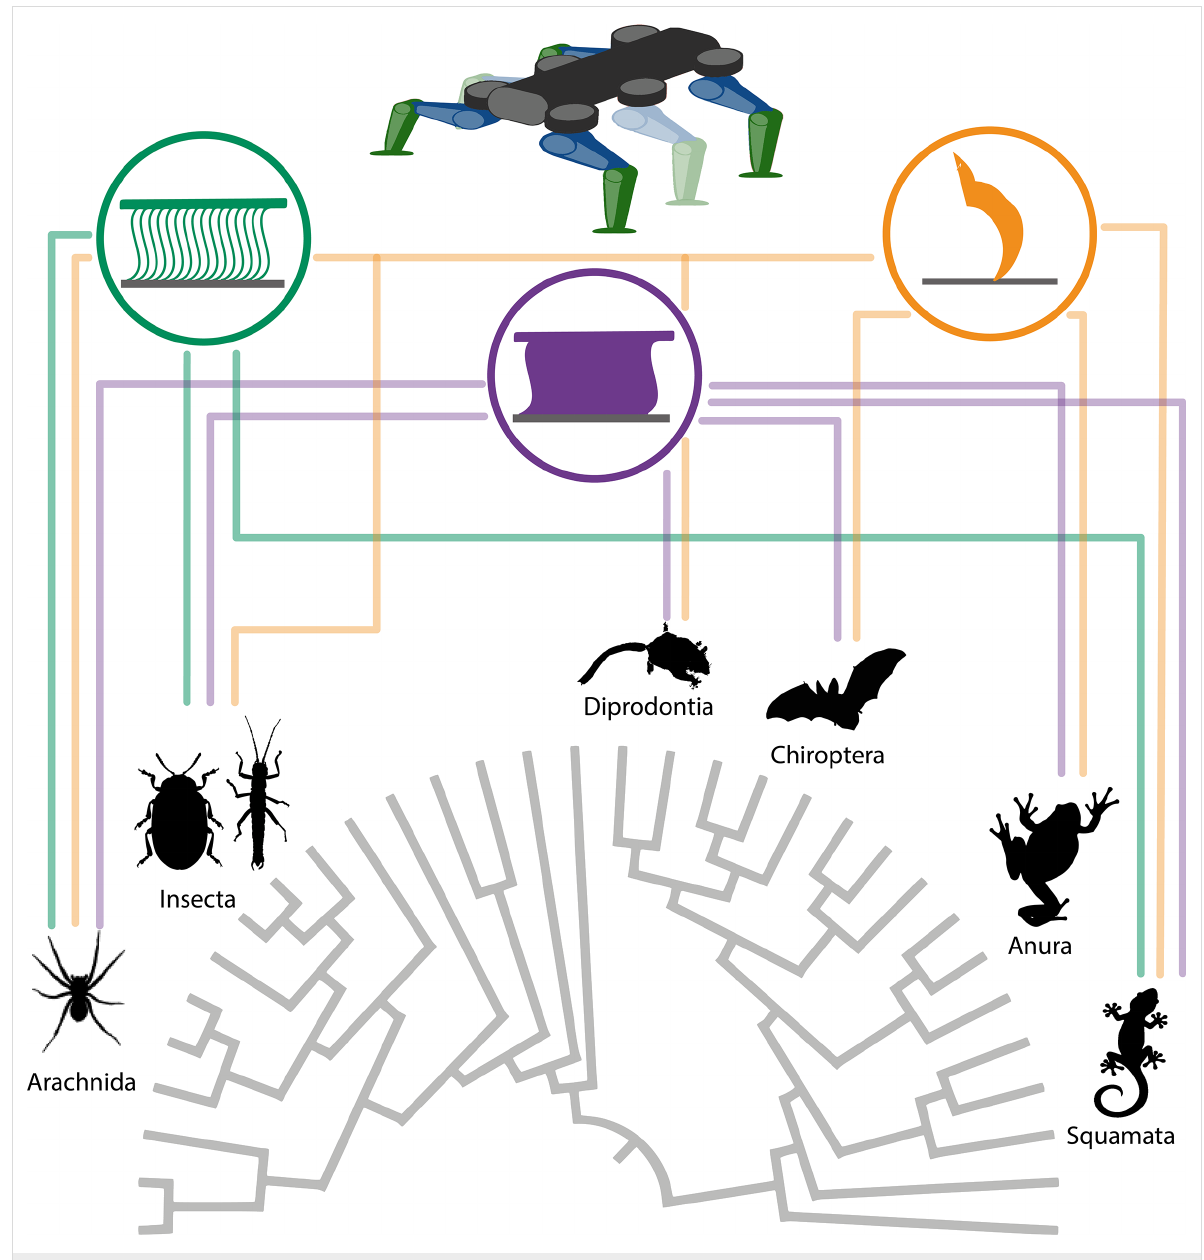
Figure 10: Sources of bioinspiration for attachment systems from the animal tree of life. Shown are the example groups in which attachment systems occur from Figure 1. The functional aspects i) hairy attachment pads (green), ii) smooth attachment pads (purple) and claws (orange), which can inspire the technical application on a four- or six-legged robot is linked by the colour mapping of the groups which include species that represent ex- amples of the mechanism and may serve as a biological source of inspiration. The green and purple icons were adapted with permission from [1], R. G. Beutel et al., “Ultrastructure of attachment specializations of hexapods (Arthropoda): evolutionary patterns inferred from a revised ordinal phylogeny”, J. Zool. Syst. Evol. Res., with permission from John Wiley and Sons. Copyright © 2001 John Wiley & Sons. This content is not subject to CC BY 4.0. The schematic robot was redrawn after [294] (© 2020 Billeschou et al., published by MDPI, distributed under the terms of the Creative Commons Attribution 4.0 International License,